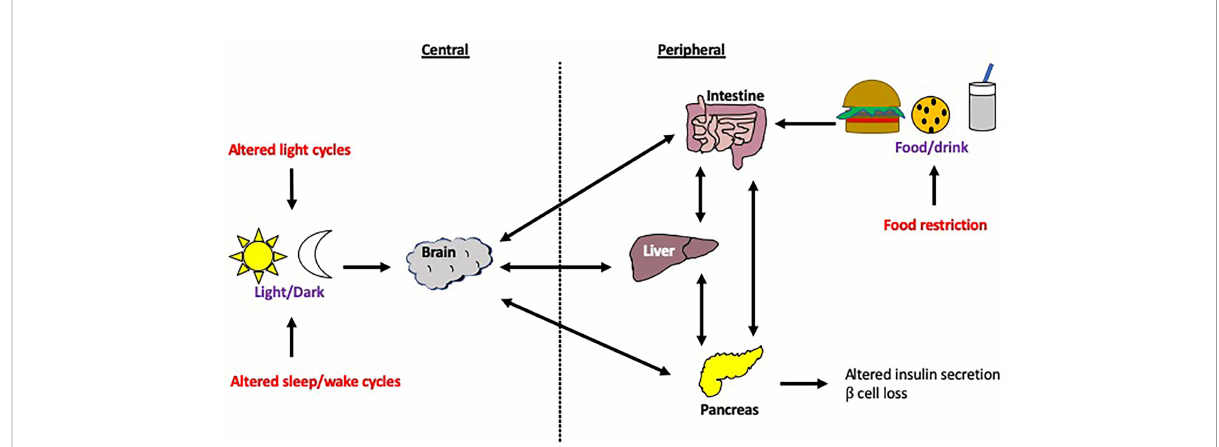
FIGURE 7 Modulation of host circadian rhythms. Circadian rhythms can be modulated through a number of interventions, including changes to the central clock via changes in the light/dark cycle or sleep/wake cycle, as well as changes to peripheral clocks e.g. food restriction. Disruption to the central clock can lead to disconnection from the peripheral clocks and vice versa. These changes to the circadian rhythm are often experienced by those with jet lag or in overnight shift workers.